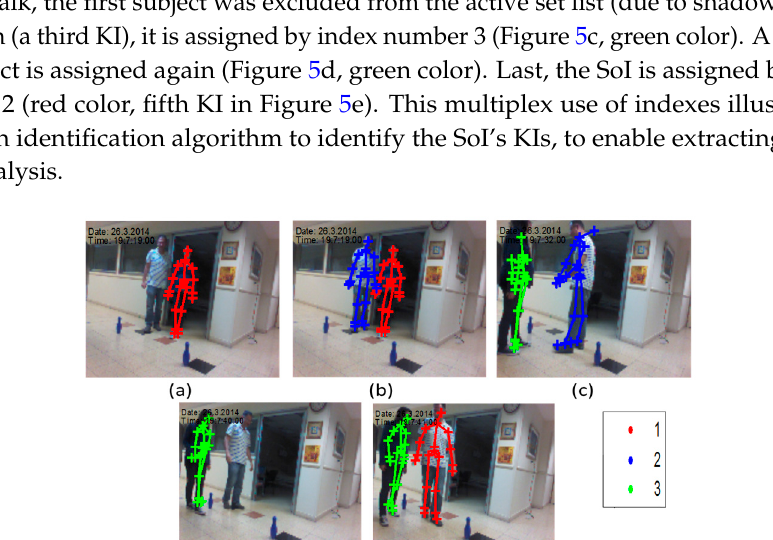
Figure 5. The five different subject indexes assignments, which represent different KIs, for the two